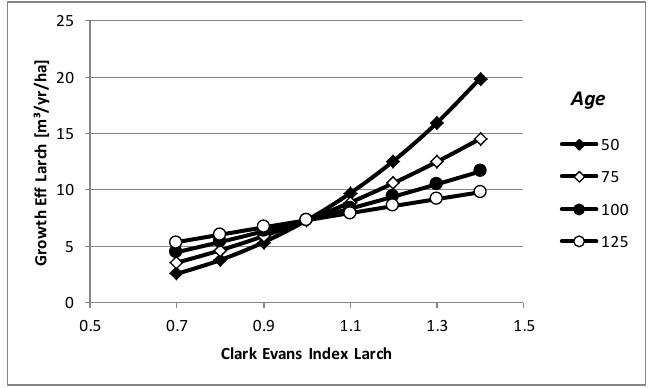
Figure 8. Growth efficiency of larch depending on its spatial distribution and age.